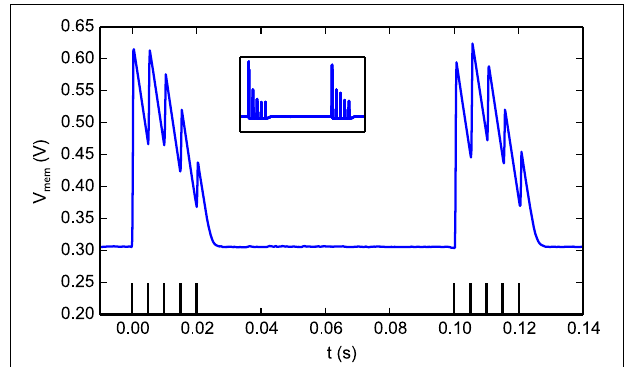
FIGURE 10 | The effect of short-term depression on EPSC magnitudes. Two bursts separated by 100 ms were sent to a programmable synapse. Each burst has 5 spikes with an inter-spike interval of 5 ms. Within a burst, The jumps in the neuron V mem gradually get smaller as the synapse is depressed and the magnitude of the EPSCs it generates decreases. After the first burst, the synapse efficacy recovers as can be seen in the response to the second burst. The figure inset shows the derivative of the membrane potential which is equivalent to the synaptic EPSCs (minus the neuron